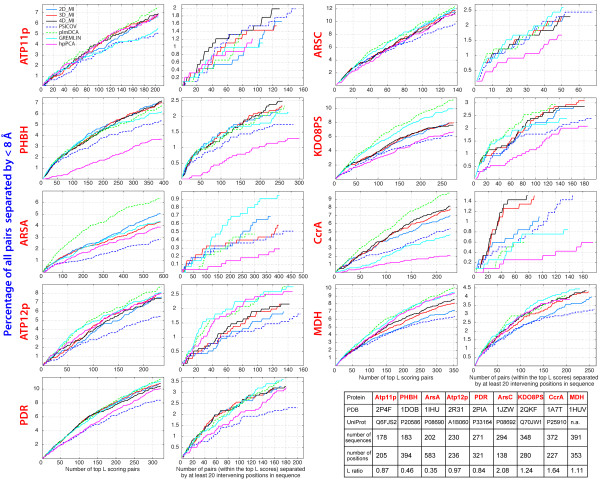
Detection of close contacts by covariation maps. Covariation analysis was carried out for the MSAs of 9 protein families. For each family, in the panel on the left, each trace shows what percentage of all residue pairs separated by less than 8 Å in the reference X-ray structure is present in the top L covarying pairs identified by each method. In the panel on the right, only pairs whose residues are separated by at least 20 intervening positions in sequence space are included in the analysis. True positives (covarying pairs corresponding to structural pairs < 8 Å apart) appear as upward displacements in the traces; false positives appear as horizontal segments in the traces. L ratio is the ratio between the number of sequences and the number of positions in each MSA.